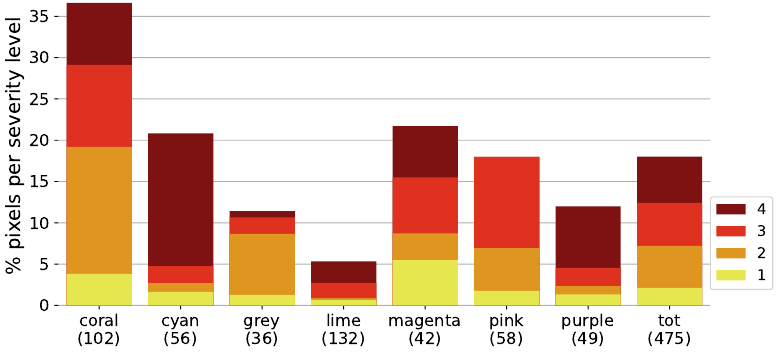
Figure 4. Distribution of the severity levels for each fold and globally. Unburnt pixels percentages are not shown and correspond to the complementary of the shown